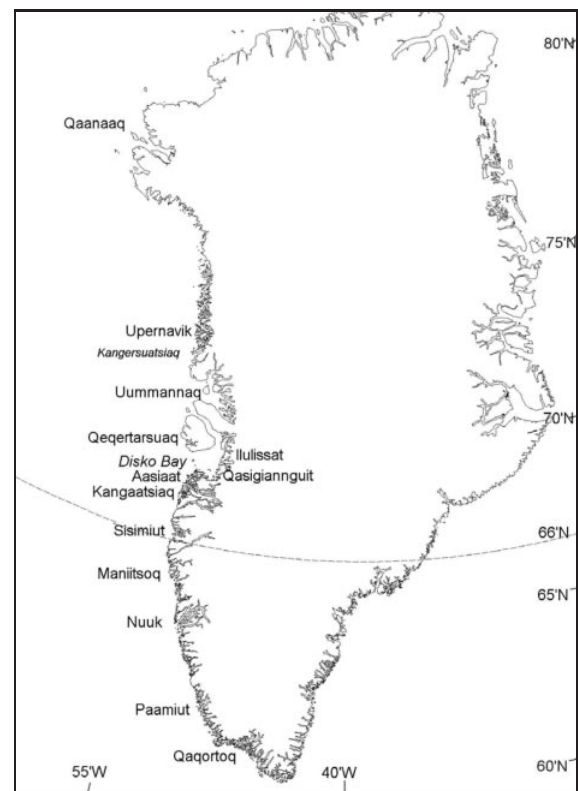
Fig. 1 . Map of West Greenland with important towns, settlements and localities indi-